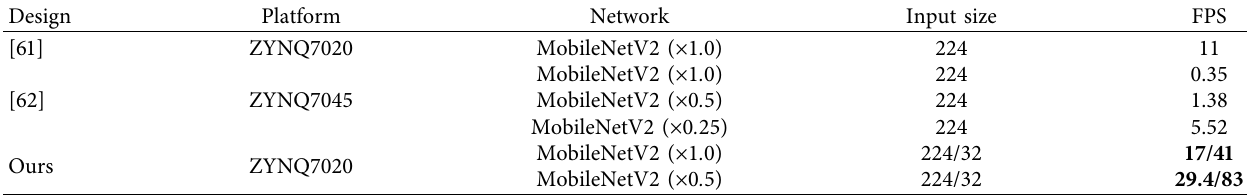
Table 7: Te real-time performance compared with the previous works.